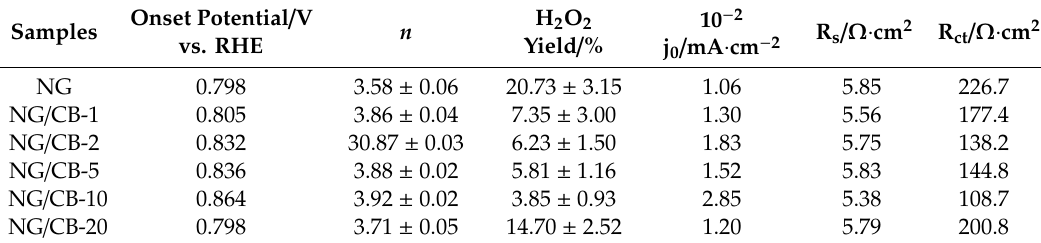
Table 1. Electrochemical properties of NG / CB-x